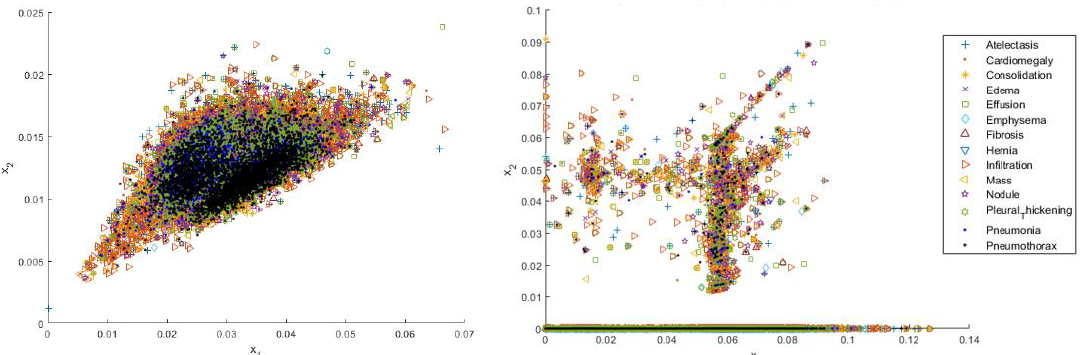
Figure 4. Distributions of four types of shallow features including SIFT, GIST, local binary pattern (LBP), and HOG (from left to right, top to bottom, respectively).